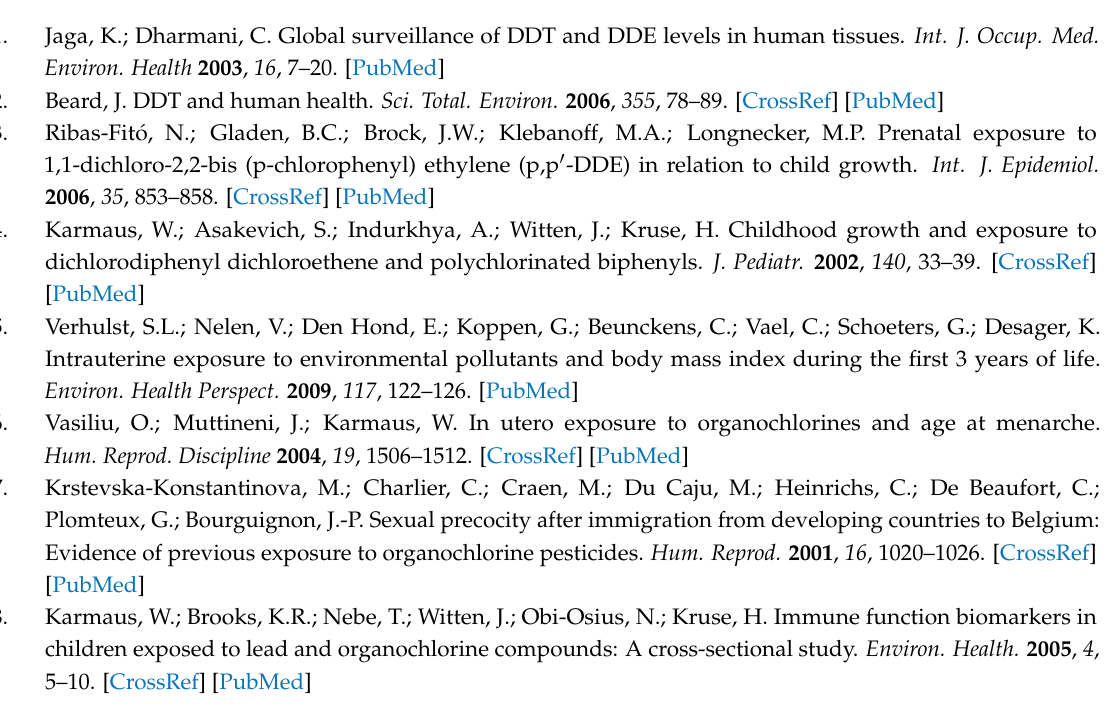
Table S1: The standardized direct, indirect, and total effects of DDE and covariates explaining height and weight from path analysis model at 10 years of age, Table S2: The standardized direct, indirect, and total effects of DDE and covariates explaining height and weight based on structural equation models; Table S3: The standardized direct, indirect, and total effects of DDE and covariates explaining FVC (L) at age 10 years using a structural equation model; Table S4: The standardized direct, indirect, and total effects of DDE and covariates explaining FEV1 (L) at age 10 years using a structural equation model; Table S5: The standardized direct, indirect, and total effects of DDE and covariates explaining the ratio FEV1/FVC at age 10 years using a structural equation model; Figure S1: Analytical path model showing statistically significant, standardized, direct, and indirect effects of DDE exposure at eight years, height and weight at eight and ten years, and FVC at age 10 years in boys; Figure S2: Analytical path model showing statistically significant, standardized, direct, and indirect effects of DDE exposure at eight years, height and weight at eight and ten years, and FVC at age 10 years in girls; Figure S3: Analytical path model showing statistically significant, standardized, direct, and indirect effects of DDE exposure at eight years, height and weight at eight and ten years, and FEV1 at age 10 years in boys; Figure S4: Analytical path model showing statistically significant, standardized, direct, and indirect effects of DDE exposure at eight years, height and weight at eight and ten years, and FEV1 at age 10